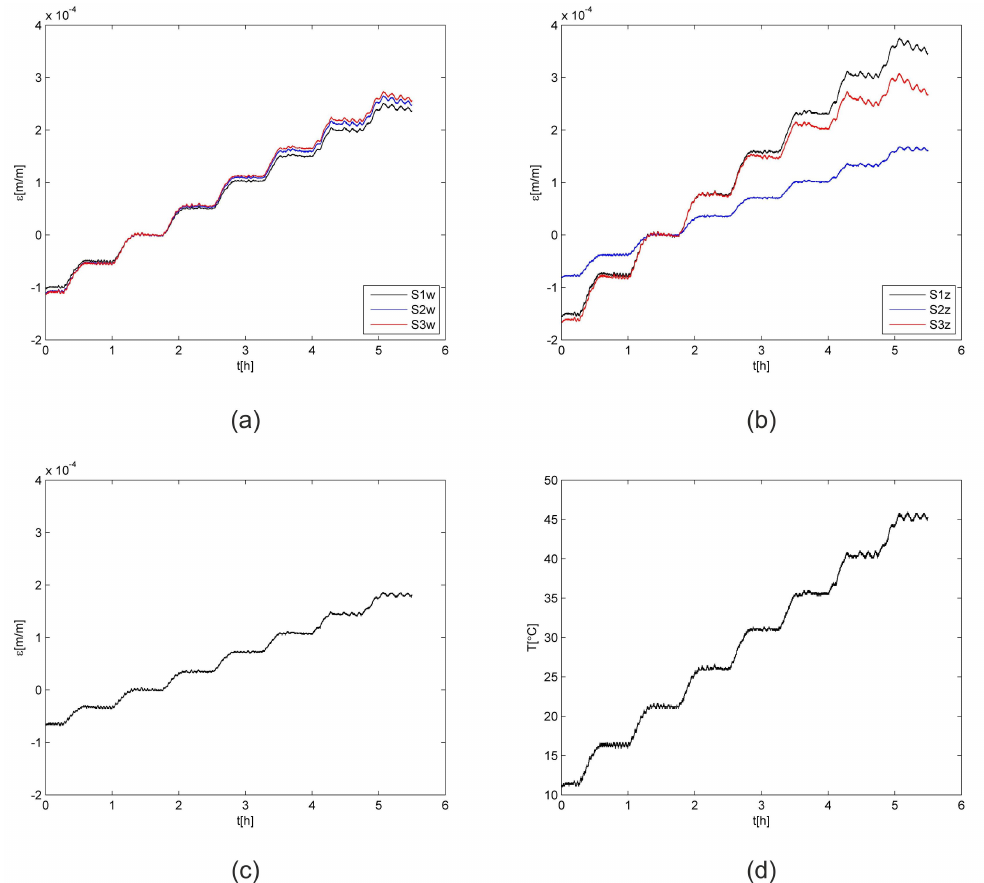
Figure 6. Total strain: ( a ) Embedded sensors, ( b ) sensors on the surfaces, ( c ) free sensor, and ( d ) temperature; S1,S2,S3—CFRP